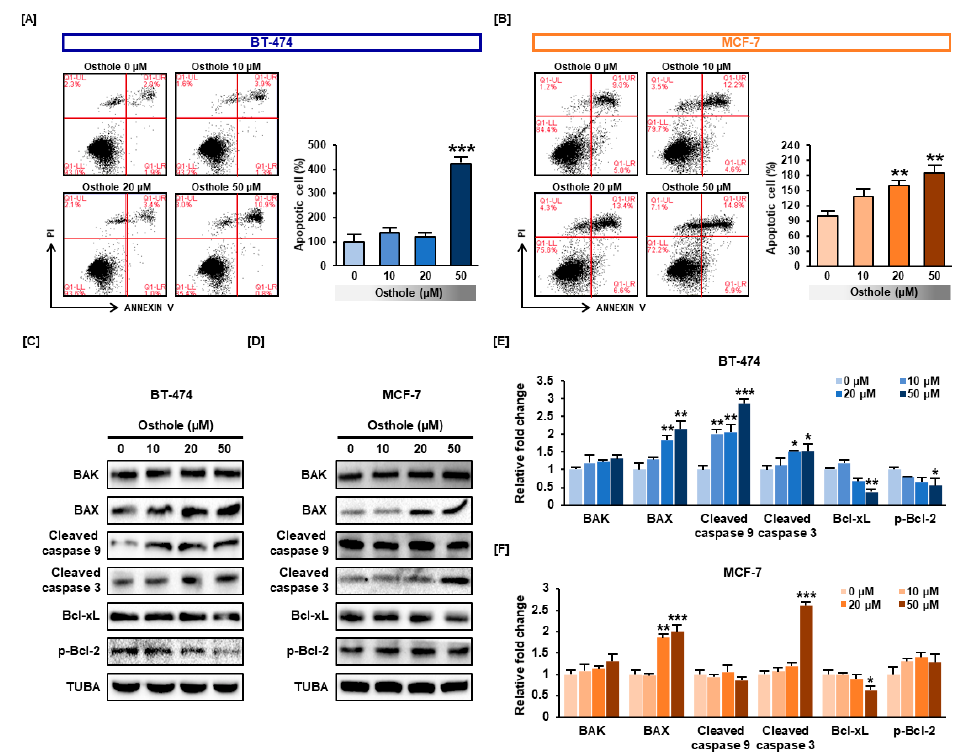
Figure 5. The apoptotic effects of osthole on human breast cancer cells. ( A , B ) Apoptotic cells were detected by flow cytometry using Annexin V / PI staining. The graph represents increased numbers of cells in the late apoptotic phase (upper right side of dot plot) in response to osthole (0, 10,